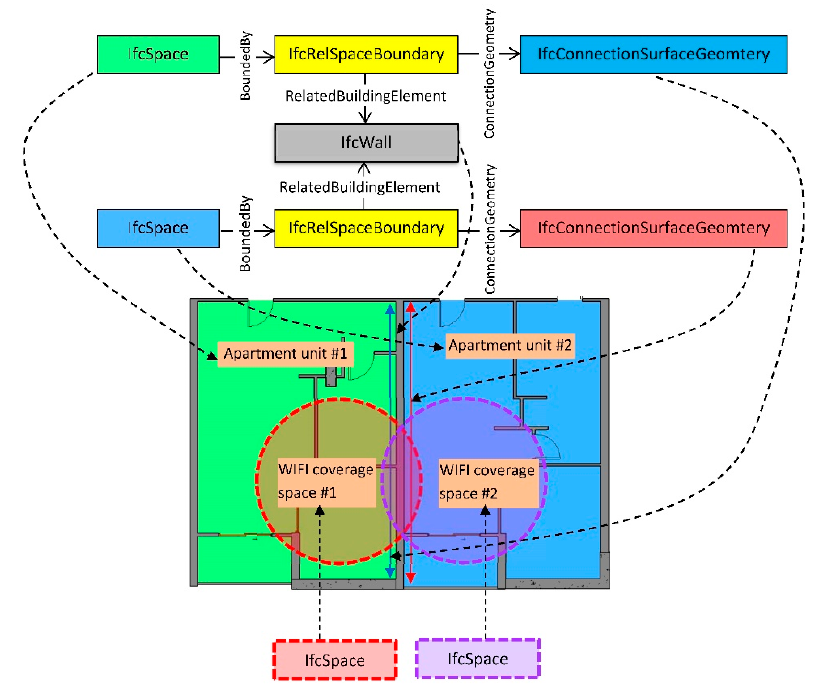
Figure 6. Modelling WIFI coverage and ownership spaces for two apartment units in IFC.